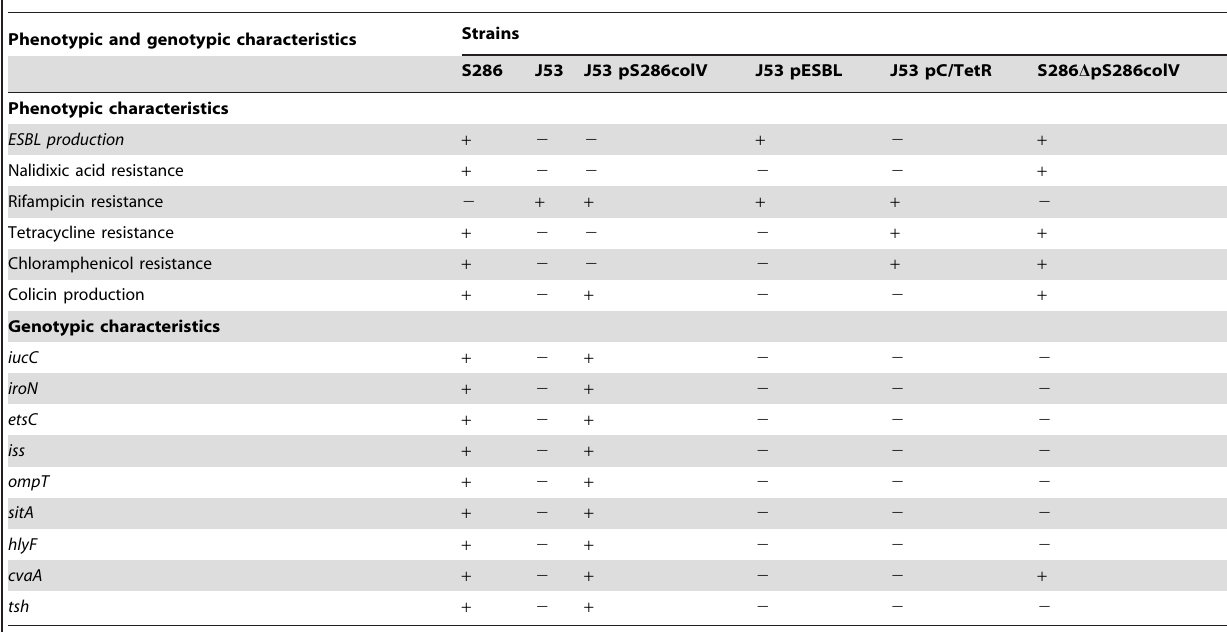
Table 1. Characteristics of the S286 transconjugants and